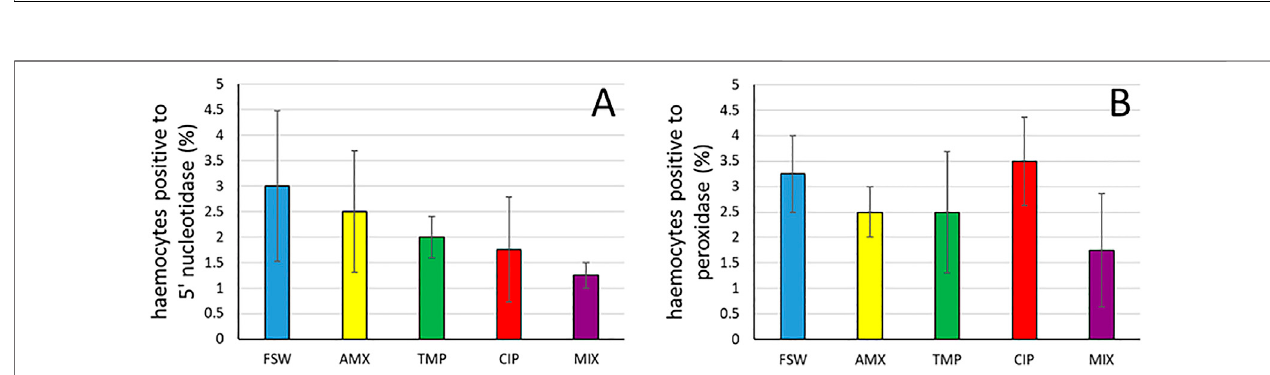
FIGURE 3 | Percentage of haemocytes positive to 5 ′ nucleotidase (A) and to peroxidase activity (B) .